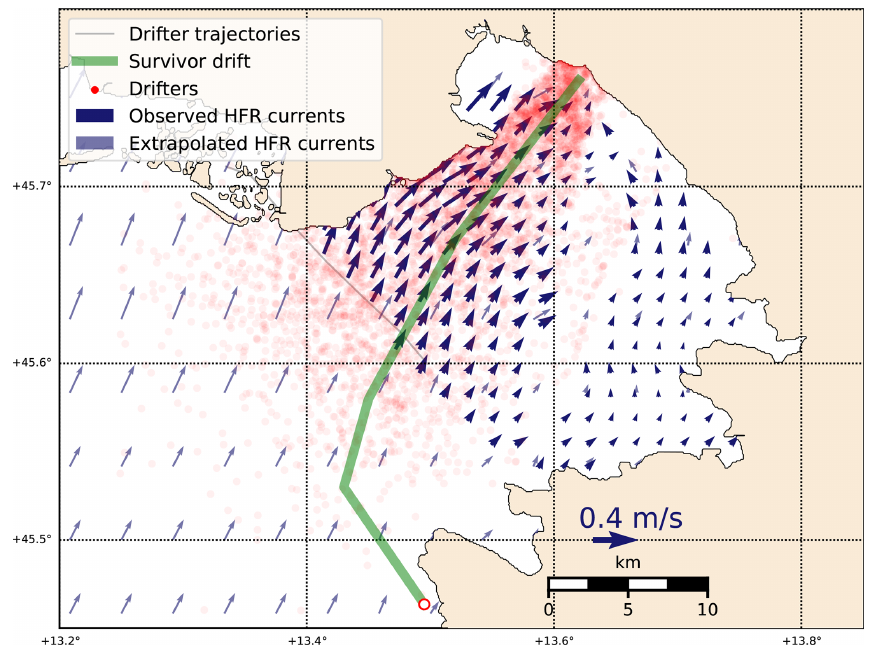
Figure 3. Using HFR currents for Lagrangian hindcasting of an accident on 29 October 2018 in the Gulf of Trieste; details in Liˇcer et al. (2020). Blue arrows denote the HFR surface current field on 29 October 2018 at 22:00UTC. Thinner (but scaled to length) light blue arrows depict nearest-neighbor extrapolated currents outside the HFR domain (every third point is plotted for clarity). Red dots denote modeled virtual drifter locations after 24h of the drift, starting from the accident location (white circle at 13.495 ◦ E, 45.4635 ◦ N). The green line indicates the survivor’s estimate of his drift trajectory. Adapted from Liˇcer et al.